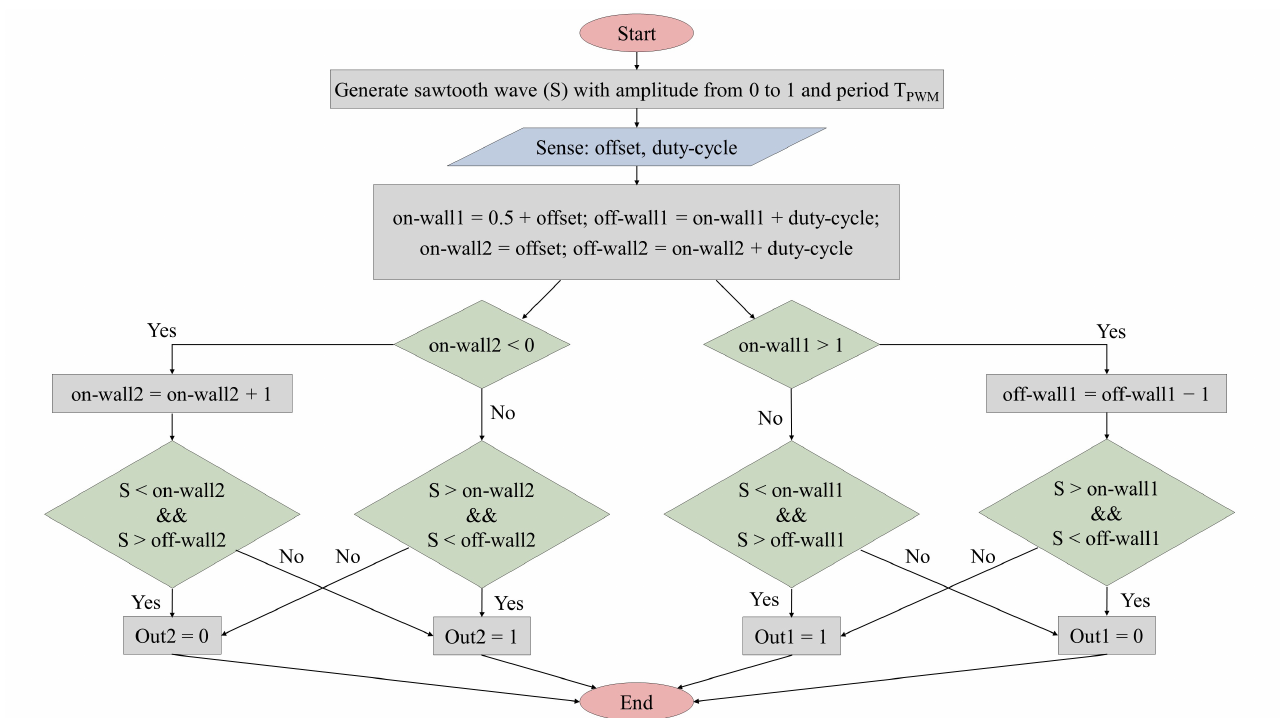
Figure 15. Asymmetric PWM generator algorithm flow chart.